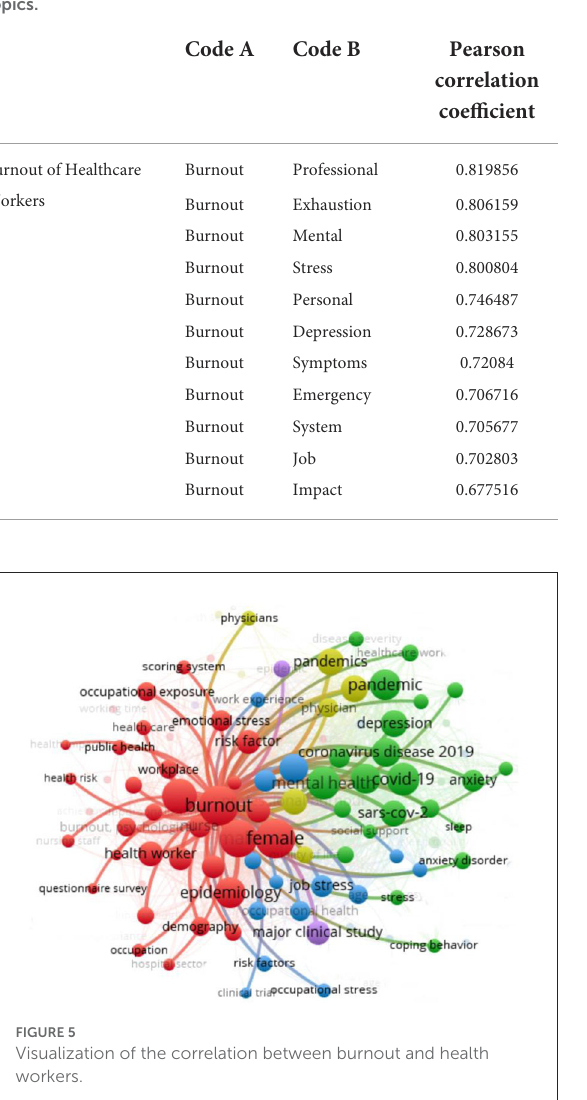
TABLE 6 Relation of burnout status of healthcare workers study topics.